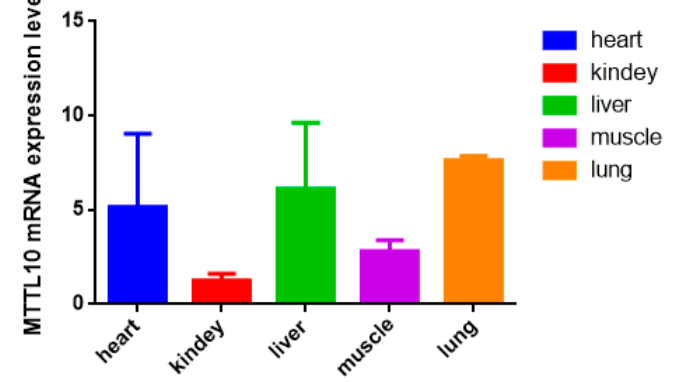
Figure 3. The expression test in different tissues of MTTL10 gene in Xianan (XN) cattle.